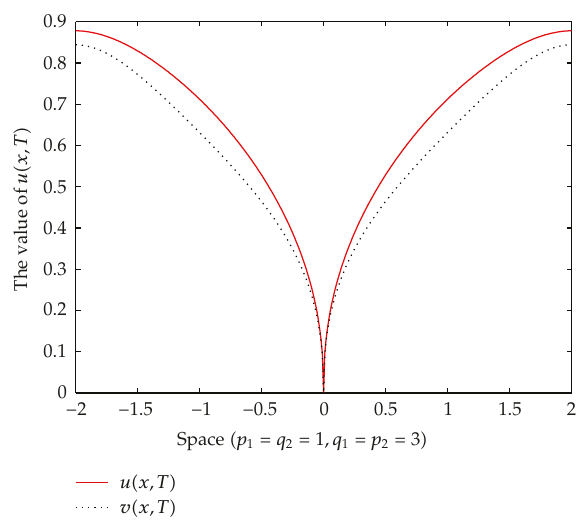
Figure 3: The value of the solution at the quenching time T (cid:3) 0 . 0660034.